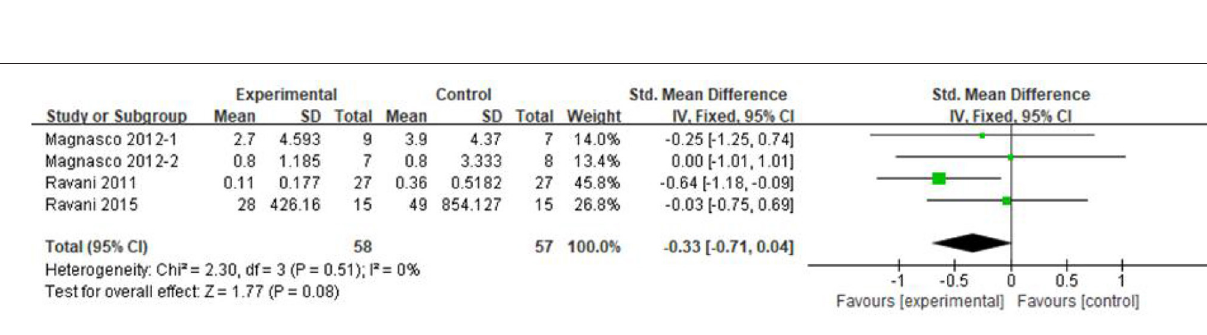
FIGURE 5 | Forest plot showing a meta-analysis for the RTX group vs. control group on the steroid dosage.